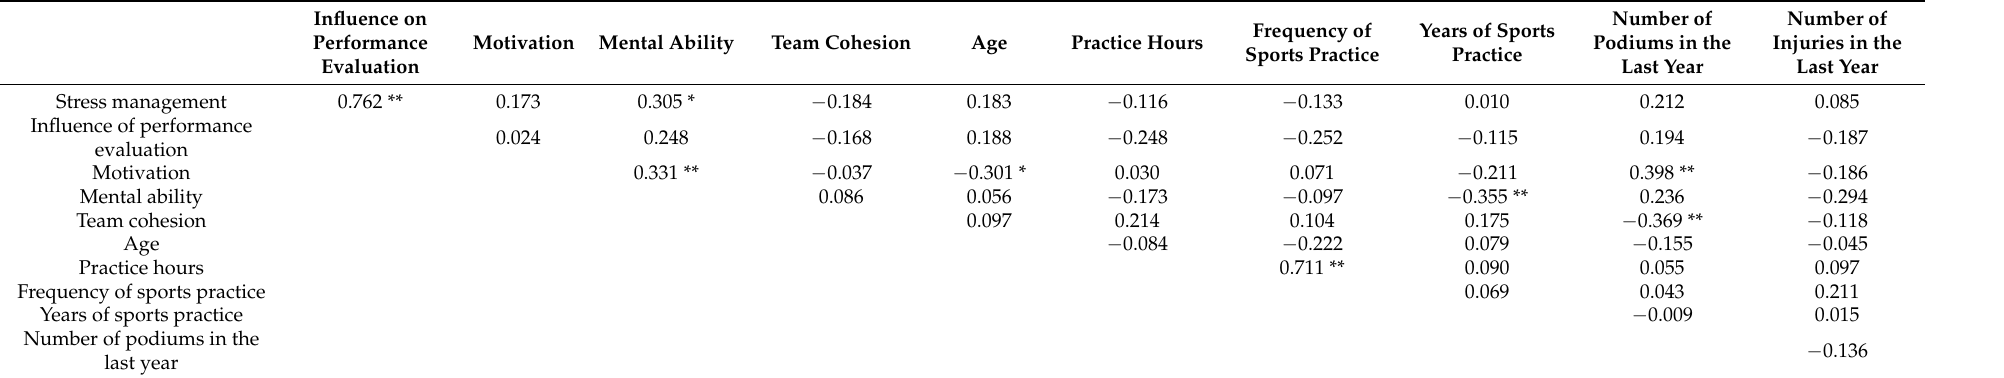
Table 3. Correlational analysis of the study